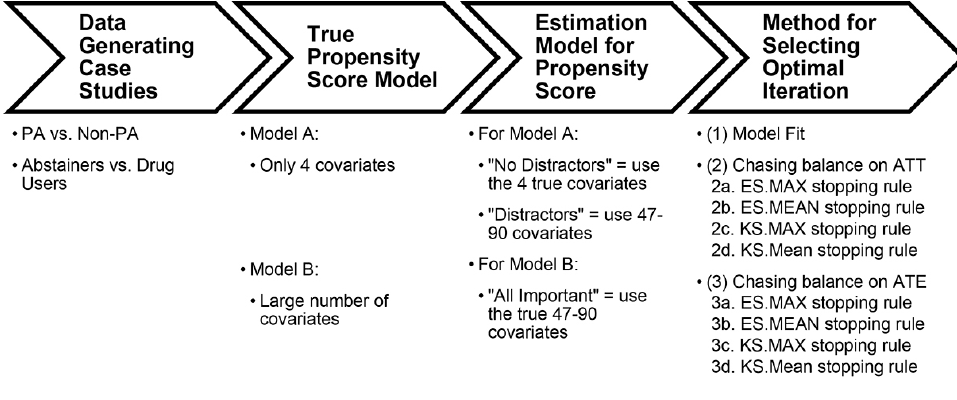
Figure 1: Overarching structure for the simulation